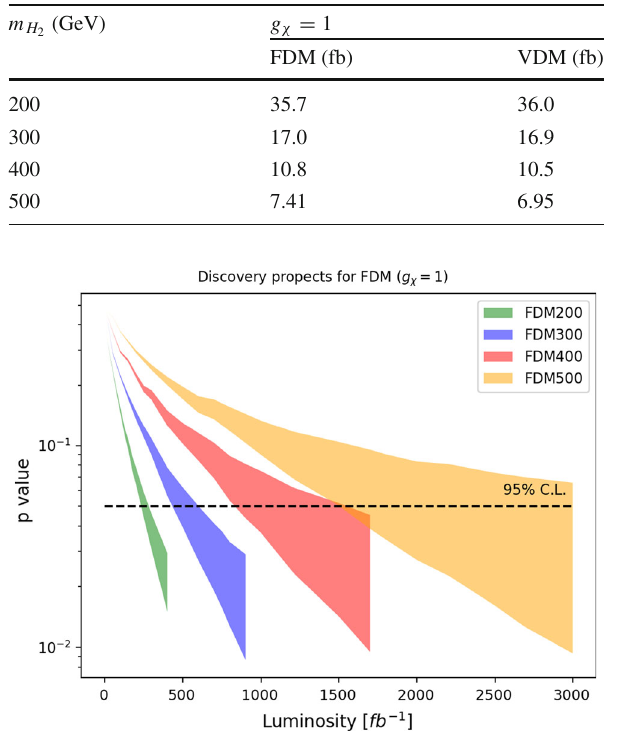
decays into DM pair. It should be noted that VDM will typ- ically have lager cross section when H 2 is lighter and have smaller cross section when the H 2 is heavier than the